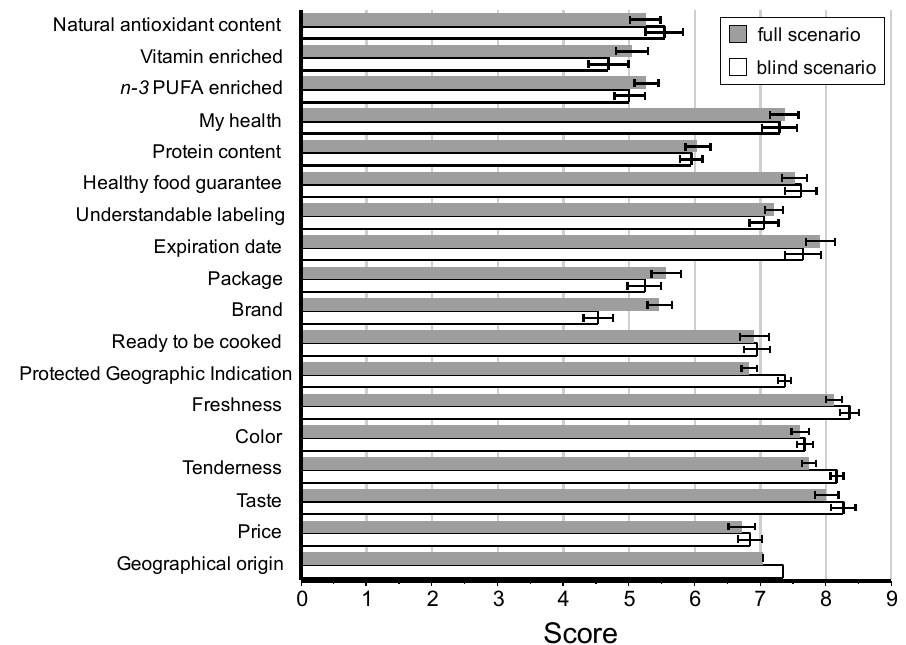
Figure 3. Evaluation of the quality cues that guide consumers to their choice of product. Scale from 1 to 9, with 1 being “not at all important” and 9 “very important”. Error bars denote Standard Error of the Mean (SEM). Information scenario: Blind : disclosure of details of the meat origin, Full : disclosure